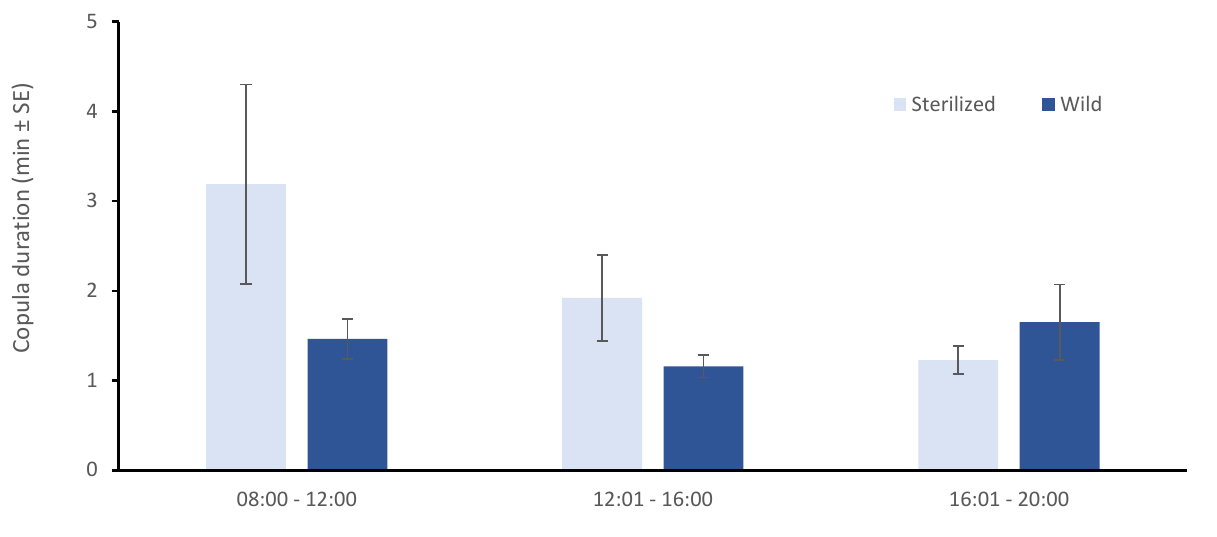
Figure 5. Effect of time of the day on copulation duration for wild and sterilized males when wild virgin females were offered in a no choice experimental set up.